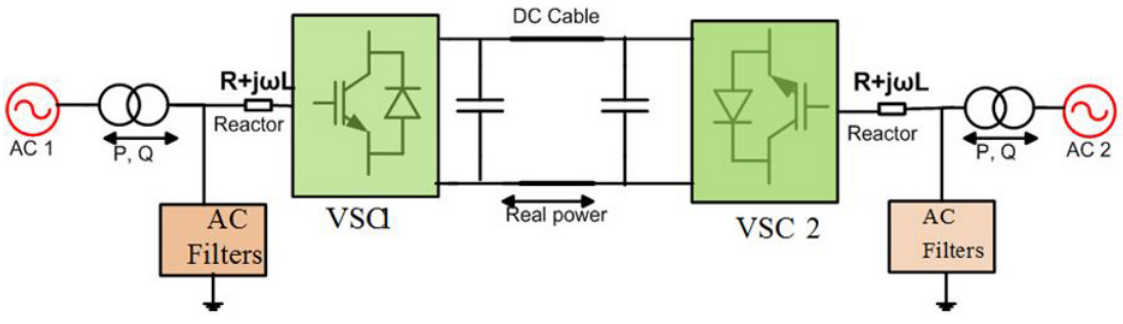
Figure 1. A schematic diagram of an HVDC Light transmission